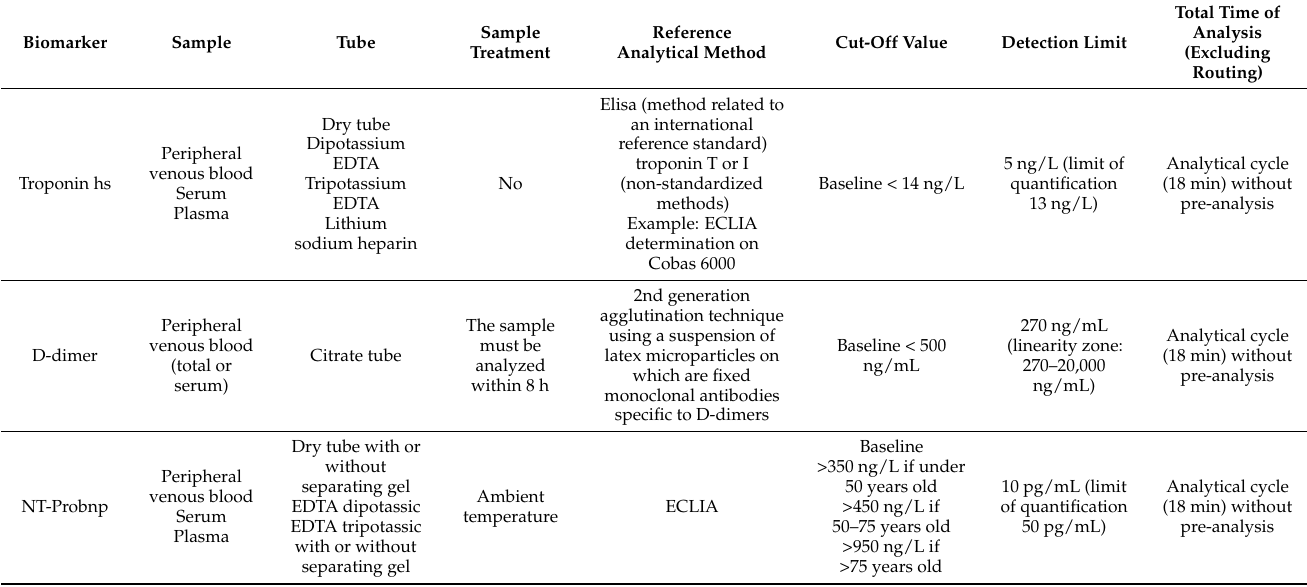
Table 1. Characteristics of the cardiac biomarkers cited by an international panel of physicians, as obtained from central